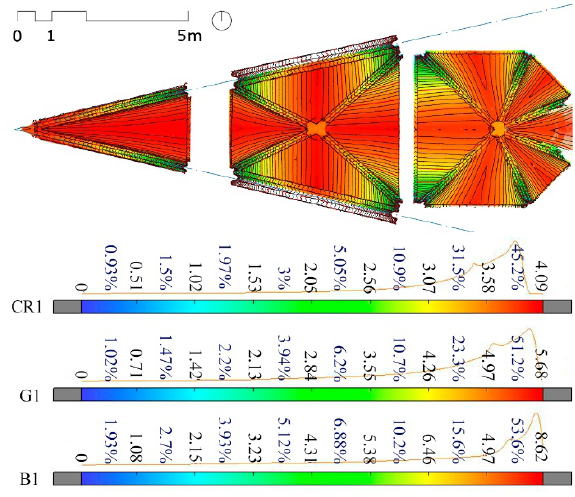
Figure 8: Data obtained by the horizontal plane comparison, superimposed with the topographic data. The maximum height obtained by the gradient of each vault corresponds to a value of 4,090m for the CR1, starting its webs at a height of 0.384m, from the minimum height of impost located at 5.407m. For the vault of the G1 ambulatory, the maximum height is 5,680m, starting the height of webs at 2,228m and with a minimum impost height of 10,172m. For the central vault B1 the maximum height is 8,620m, starting the webs at 3,783m and 16,536m of minimum height of imposts.